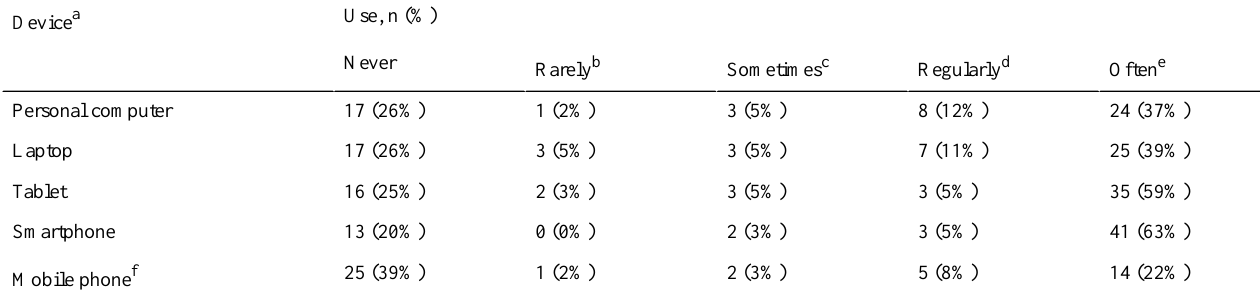
Table 1. Prior use of information and communication technology devices